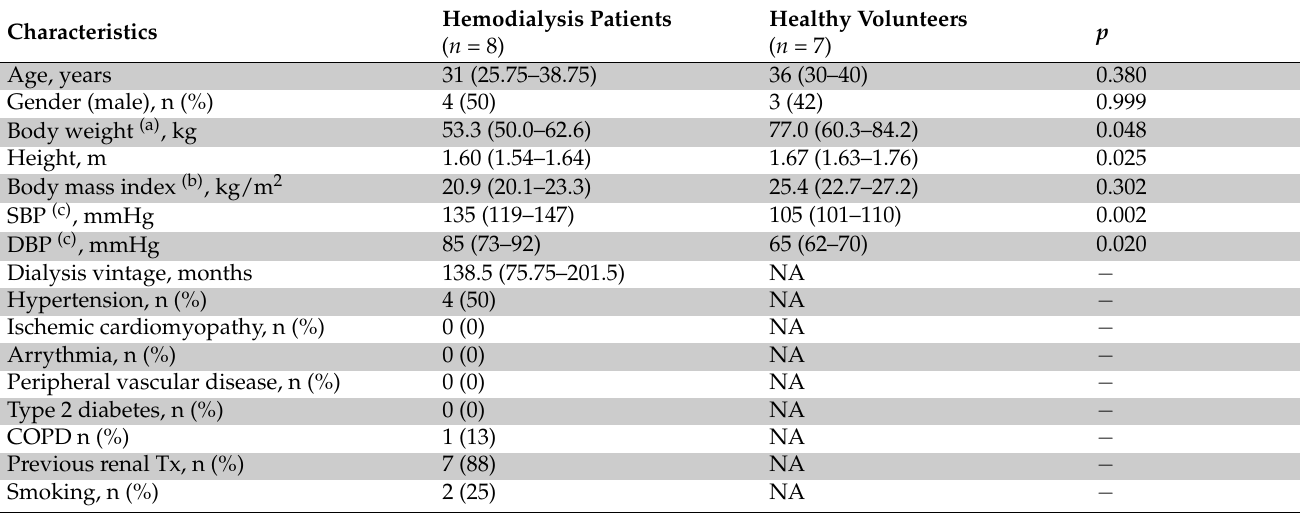
Table 1. Characteristics of participants at the start of the